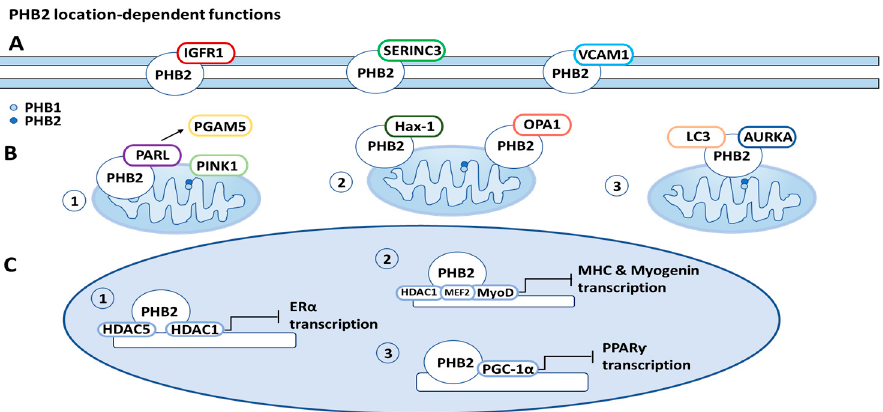
Figure 3. Prohibitin 2 (PHB2) location-related functions. ( A ) Cell membrane: PHB2 is associated with a variety of proteins on the cell membrane, including insulin-like growth factor-1 receptor (IGFR1), serine incorporator 3 (SERINC3), and vascular cell adhesion protein 1 (VCAM1). ( B ) Mito- chondria: (1) PHB2 initiates mitophagy through binding presenilin-associated rhomboid-like pro- tein (PARL), releasing PGAM5 (PGAM family member 5, mitochondrial serine/threonine protein phosphatase), and consequently stabilizing PINK1 (PTEN induced putative kinase 1). (2) PHB2 in- creases apoptosis resistance through binding optic atrophy 1 protein (OPA1) and HCLS1-associated protein X-1 (Hax-1). (3) PHB2 also initiates mitophagy through forming a tripartite complex with LC3 (microtubule-associated protein light chain 3) and aurora kinase A (AURKA). ( C ) Nucleus: